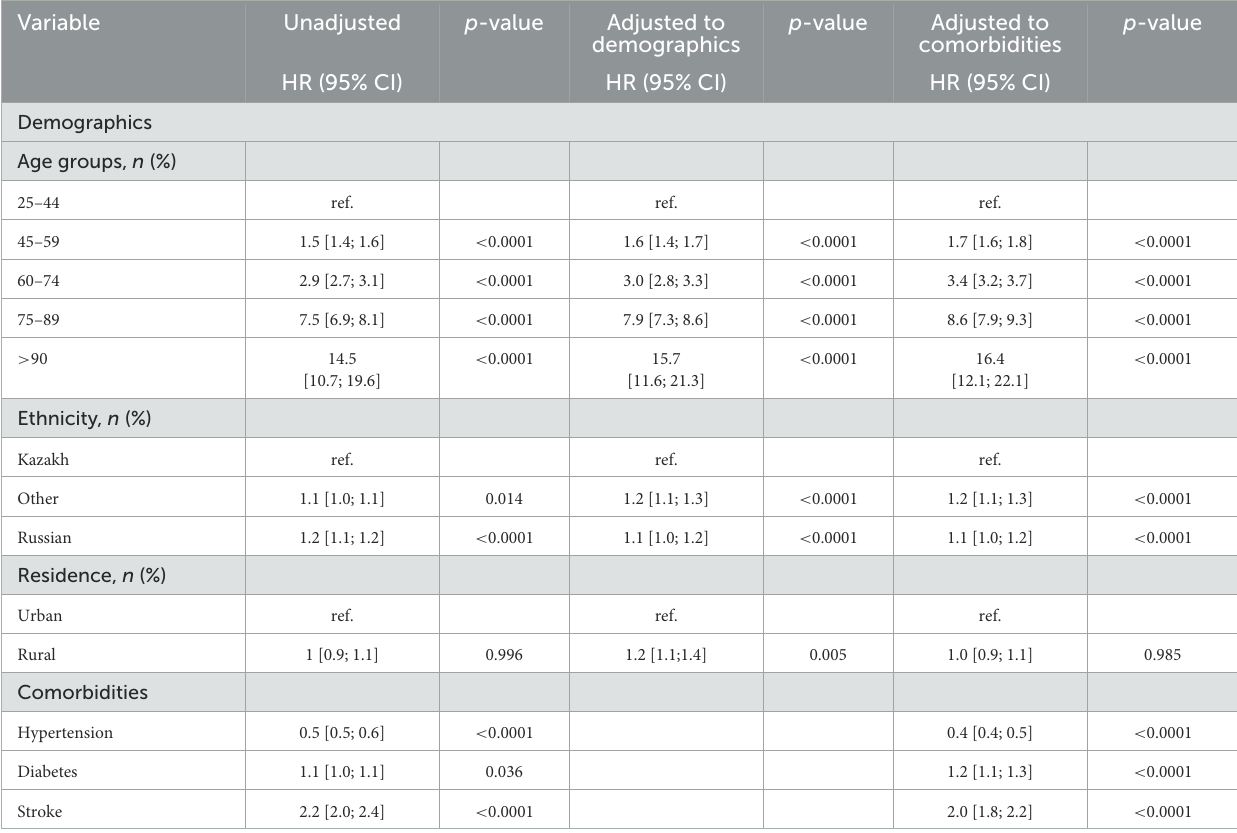
TABLE 2 Association between socio-demographic and medical parameters and all-cause mortality rates of breast cancer between 2014 and 2019.